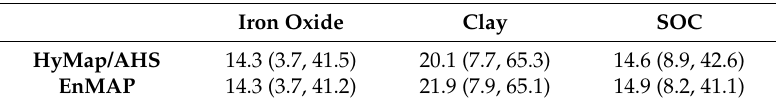
Table 2. Mean, minimum and maximum values of iron oxide (g from the derived soil products.